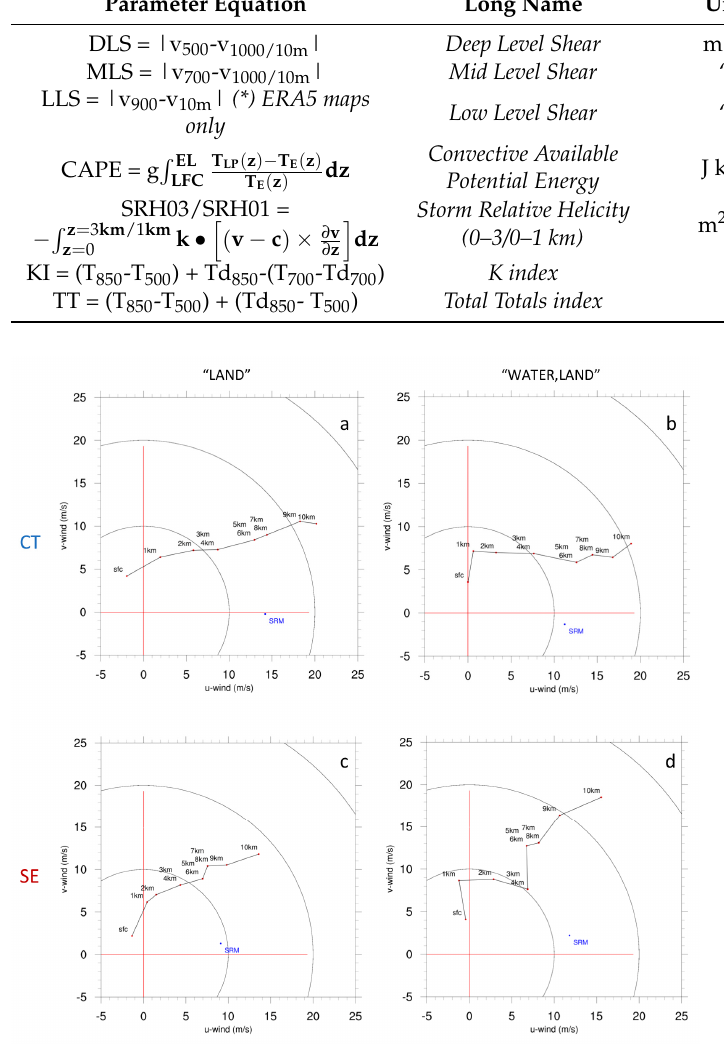
Figure A1. Composite hodographs at Pratica di Mare ( top ) and Brindisi/Galatina ( bottom ) from RAOB sounding. The blue points near the x − axes represent the storm relative motion (SRM). The events are divided into inland tornadoes (( a , c ); 33 events in CT and 24 in SE) and waterspouts making landfall (( b , d ); 30 events in CT and 10 in